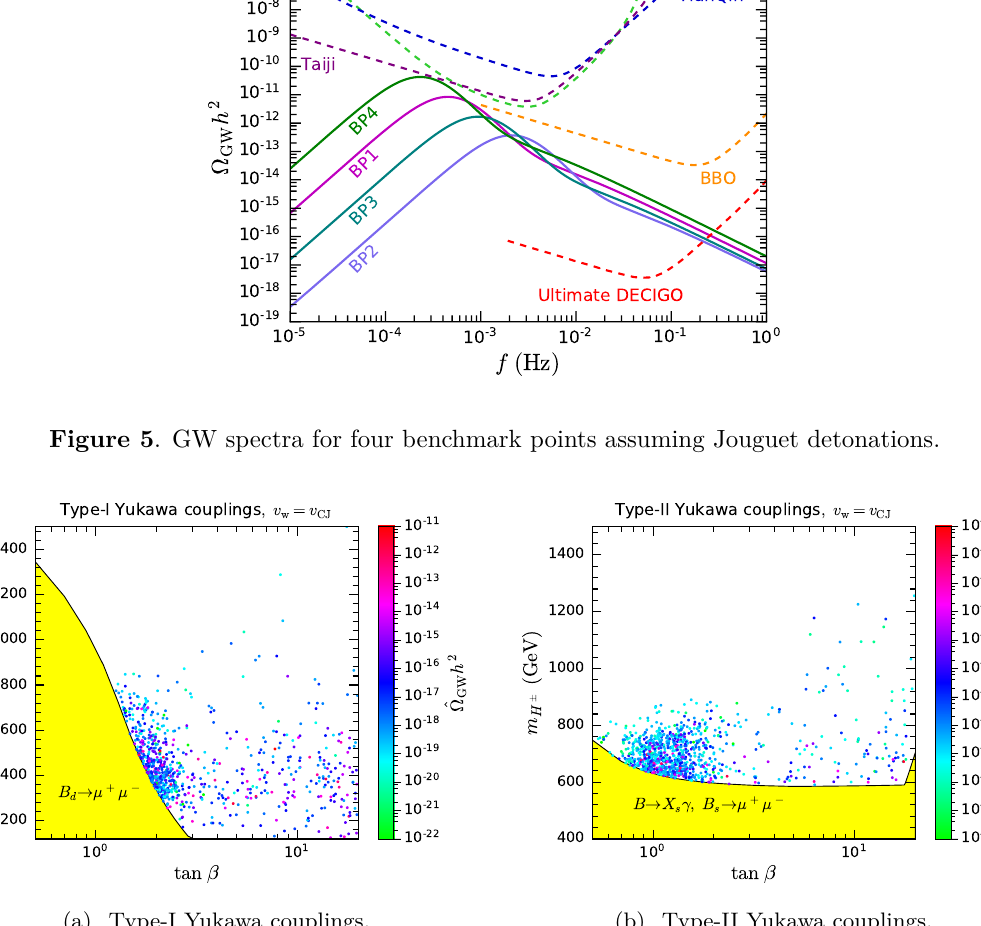
plane for type-I (a) and type-II (b) Yukawa H